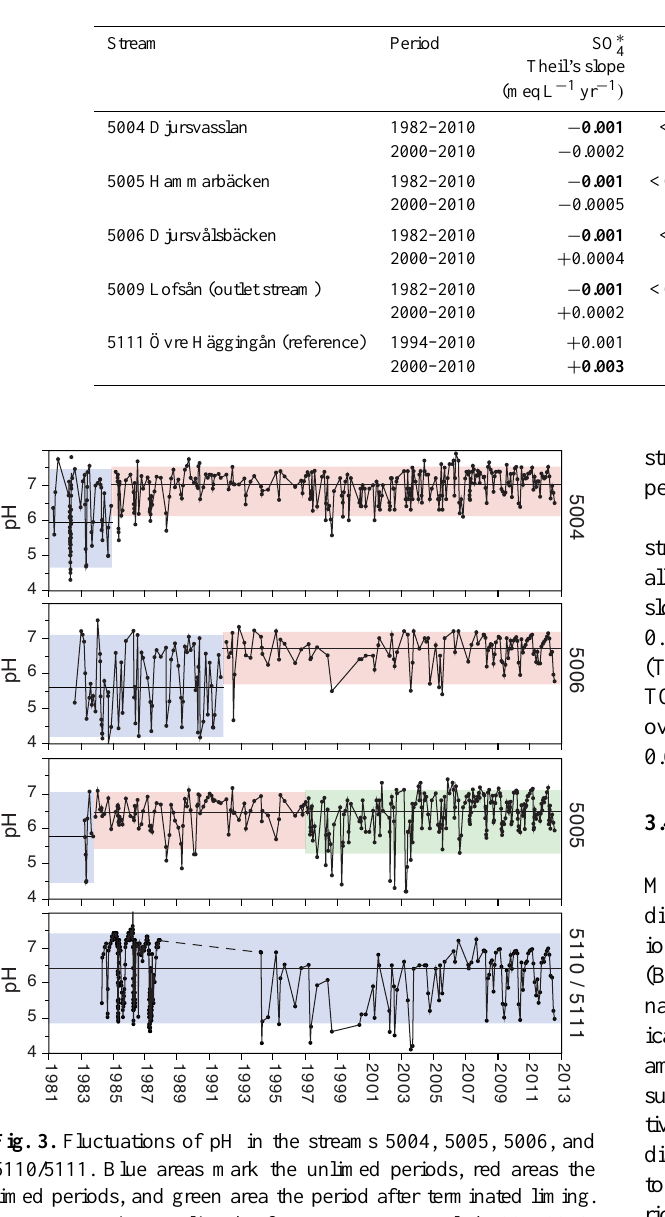
Table 2. Theil’s slope estimates of long-term trends of non-marine sulfate (SO ∗ the whole period and during 2000–2010. The probabilities ( p ) of change are associated with the seasonal Mann–Kendall test; significant changes in bold ( p <0.05).